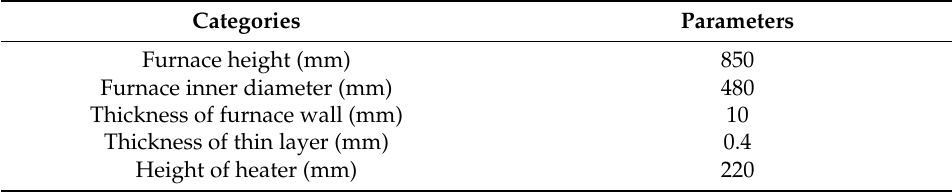
Table 1. The geometric dimensions of the PVT furnace.